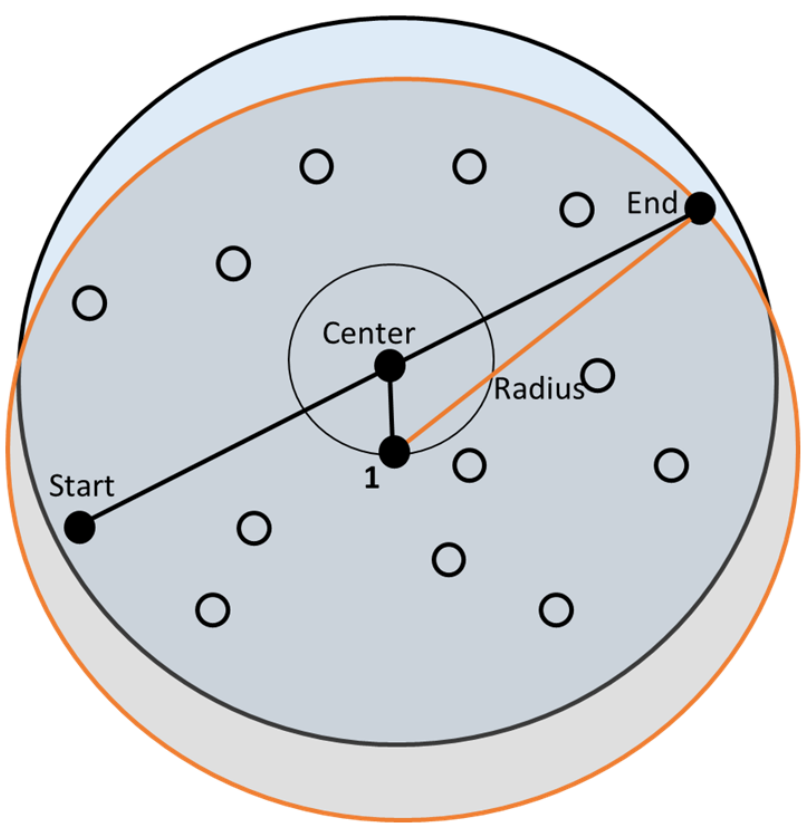
Figure 2. Determination of the search center and search radius.